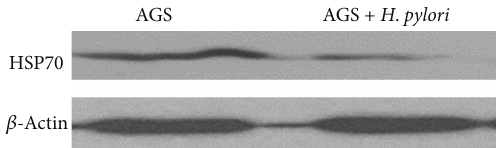
Figure 2: H. pylori effects on HSP70 expression in AGS cells. AGS cells were incubated with H. pylori (bacteria/cell ratio 200 : 1) or medium in absence of the bacterium for 48 h. The expression of HSP70 was measured by Western blotting. Anti- 𝛽 -actin antibody was used to measure 𝛽 -actin as a protein-loading control.